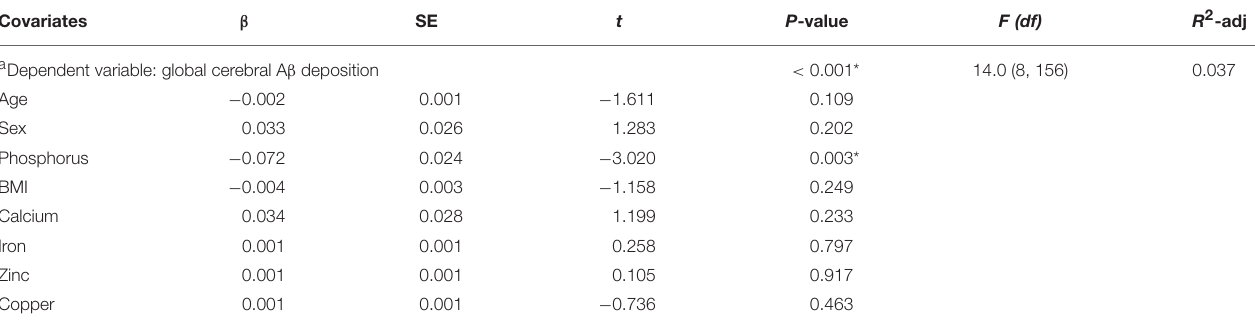
TABLE 5 | Multiple regression analyses of phosphorus, elements, and body mass index (BMI) with global cerebral A β deposition in cognitively impaired subjects. Covariates β SE t P -value F (df) R 2